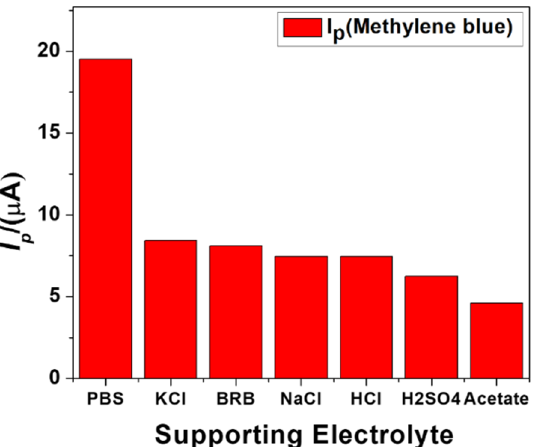
Figure 4. Effect of the various electrolytes on peak current response of 10 μ M MB at 125 mV/s scan rate, 5 s deposition time, and − 0.5 V accumulation potential. rate, 5 s deposition time, and − 0.5 V accumulation